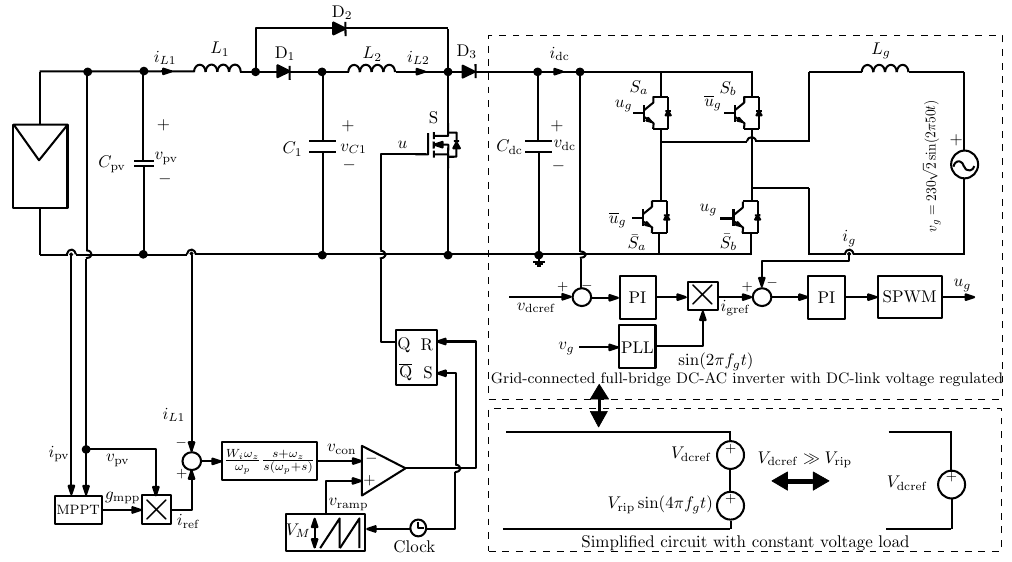
Grid-connected full-bridge DC-AC inverter with DC-link voltage regulated